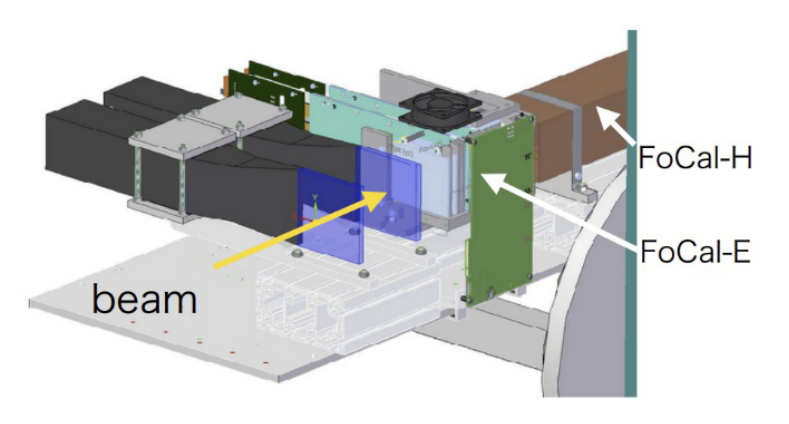
Figure 2. A schematic layout of FoCal configuration for data acquisition during TestBeam 2021.